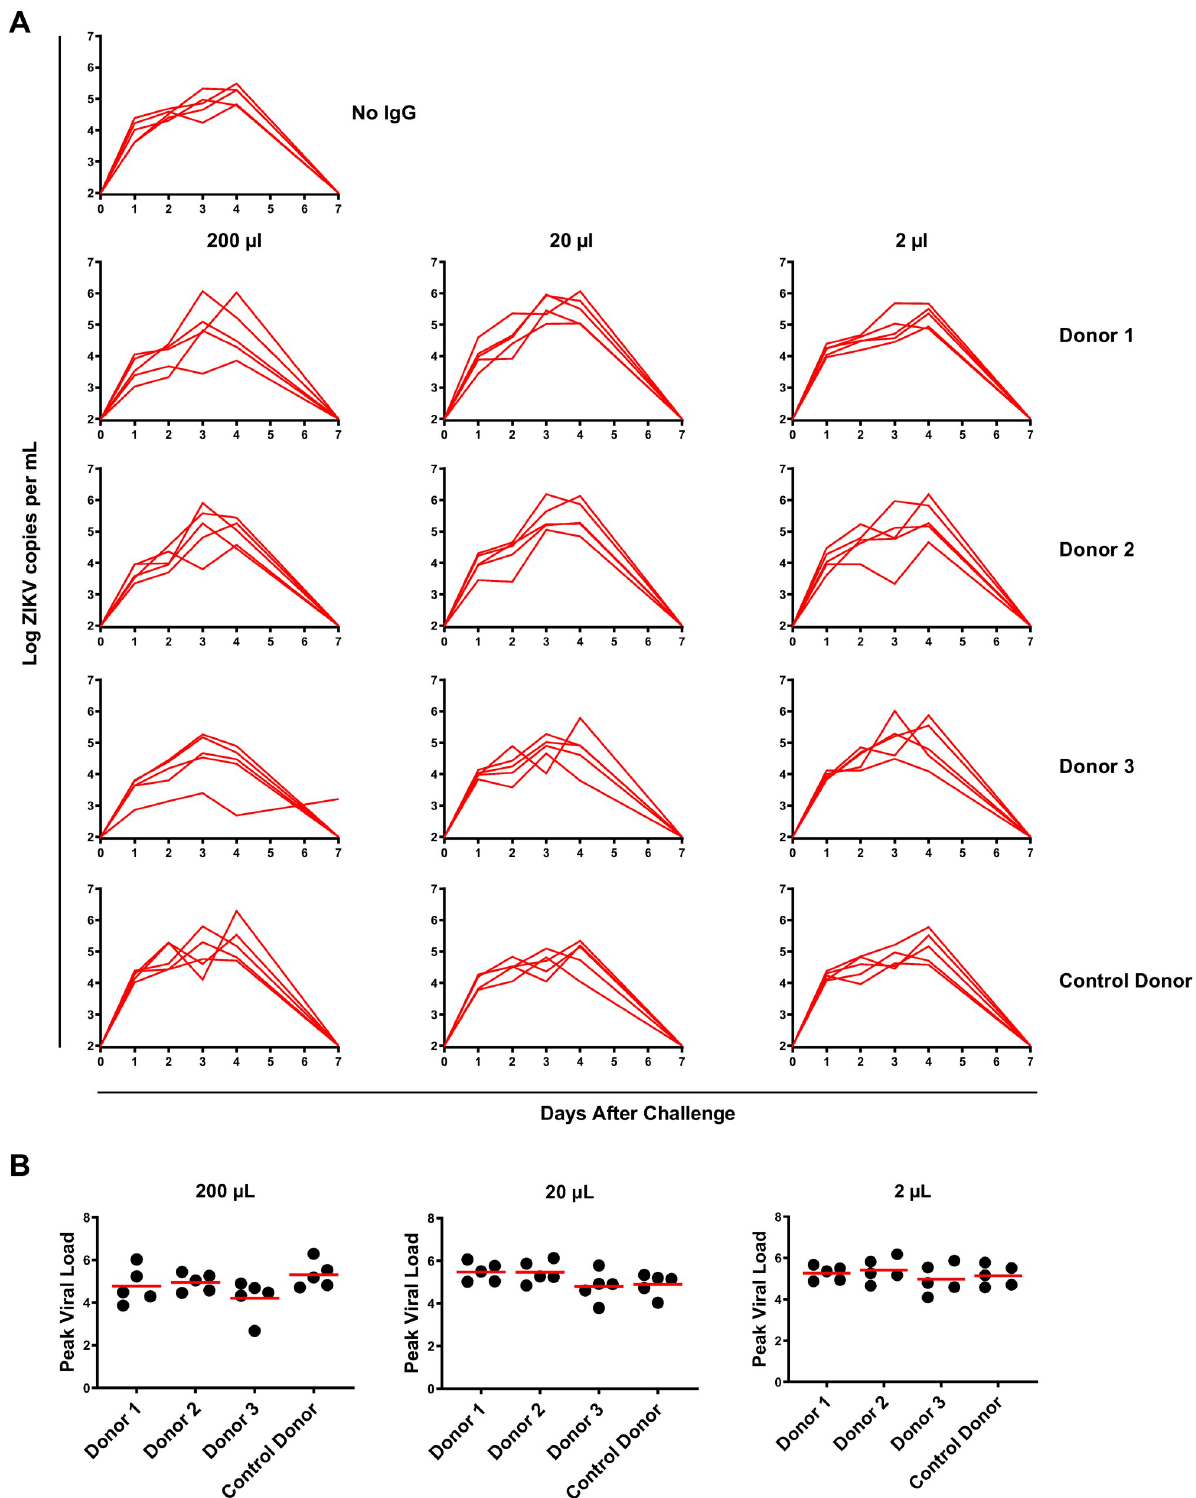
Fig 6. Passive transfer of anti-DENV IgG in BALB/c mice. Anti-DENV IgG isolated from 3 donors were passively transferred into BALB/c mice in 3 different doses (200 μ l, 20 μ l, and 2 μ l) equivalent of (200 μ g, 20 μ g and 2 μ g) dose. One-hour post IgG transfer, mice were challenged i.v. with 10 2 PFU ZIKV-BR. (A) ZIKV mRNA viral load in serum. (B) Peak viral load comparison in all recipients. Data is representative of one experiment with n = 5 animals per group. All injections were performed in the final volume of 200 μ l diluted in saline. Each line or dot represents an individual mouse.